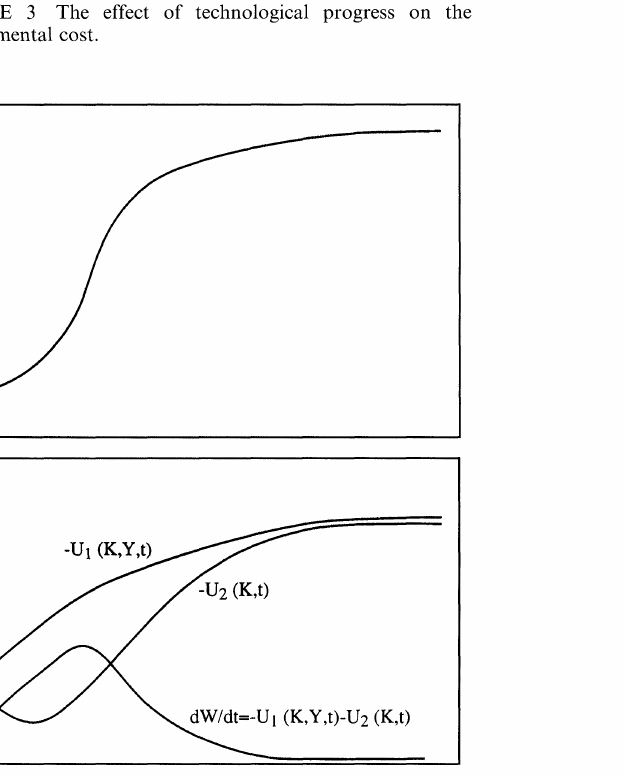
FIGURE 3 The effect of technological progress on the environmental cost.